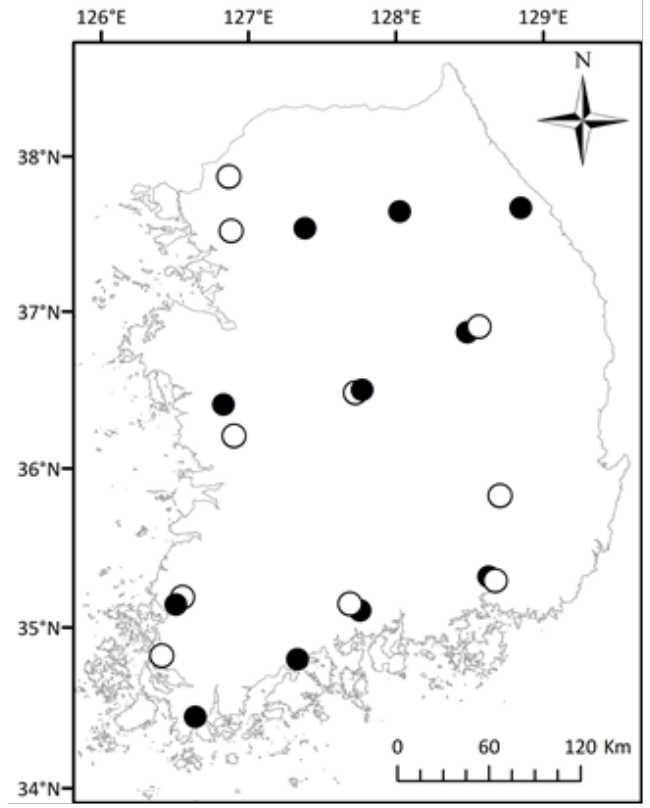
Figure 2. Sampling sites for Rana uenoi (11 sites, close circle) and Bufo sachalinensis (10 sites, open circle). Sampling was conducted between March and April 2018. Table 1. The detailed sample size and CTmax of Rana uenoi ( n = 270) and Bufo sachalinensis ( n = 240) and associated sample site information (coordinates, altitude, daily average temperature ( ◦ C), daily precipitation (mm) and daylight hours (h)) during tadpole collection. The values of CTmax are presented as mean ± SD. Complete dataset available from Mendeley Data: [33]).